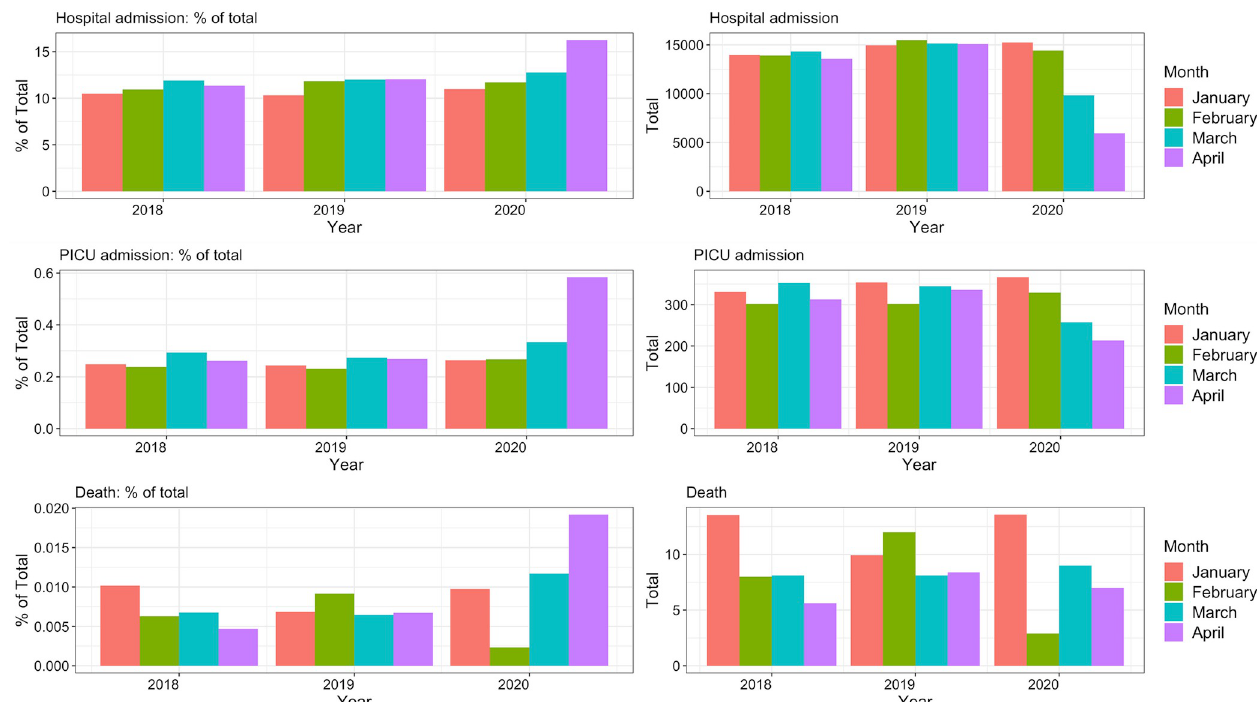
Fig 4. Hospital admissions, intensive care admissions, and deaths in the ED for the period January–April over a 3-year period. Percentages of total ED attendances (left) and absolute numbers (right) of children admitted to hospital (top), PICUs (middle), or died in the ED (bottom); comparing the 28-day mean numbers for the months of January–April for 2018 vs. 2019 vs. 2020. ED, emergency department; PICU, pediatric intensive care